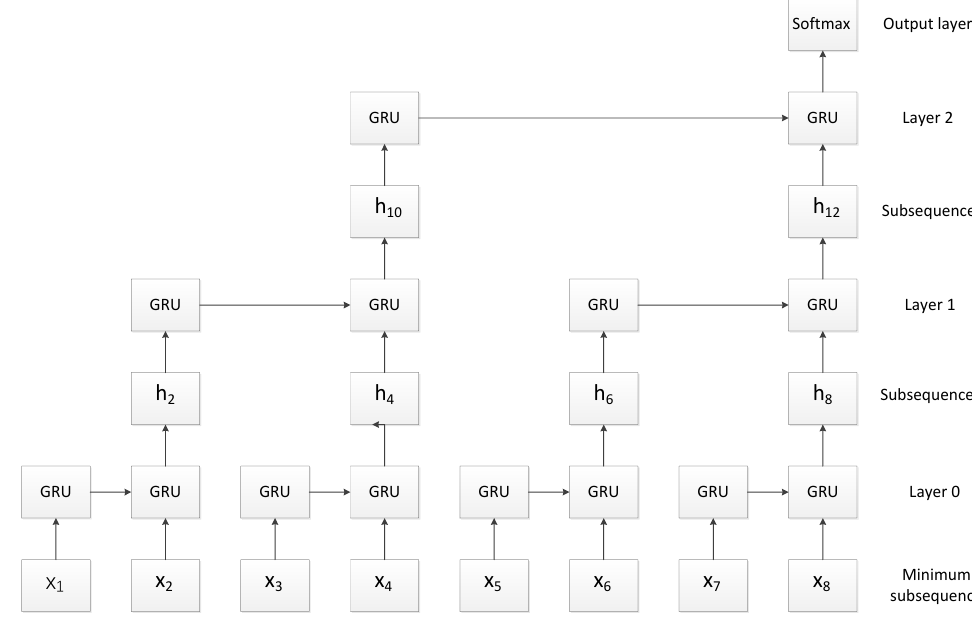
Figure 3. SRNN structure